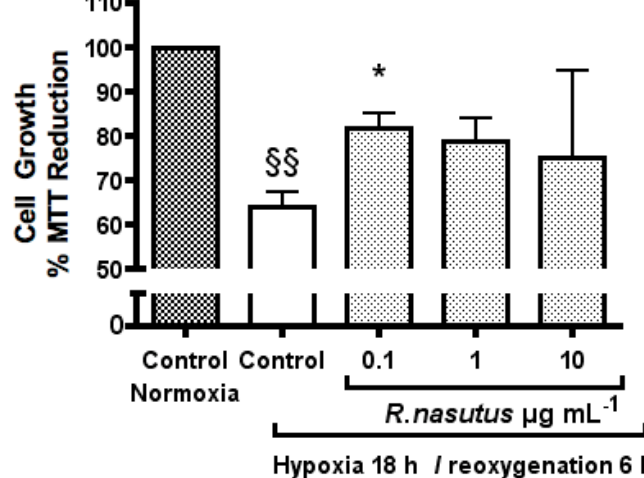
Figure 2. The Protective effect of R. nasutus against cell death induced by 18-hours hypoxia and 6-hours reoxygenation, measured using MTT assay. §§ One-way ANOVA Dunnett’s multiple comparison Post hoc test normoxia control vs. hypoxia control P < 0.01 n = 6. * ANOVA Dunnett’s multiple comparison Post hoc test compared to hypoxia control P <